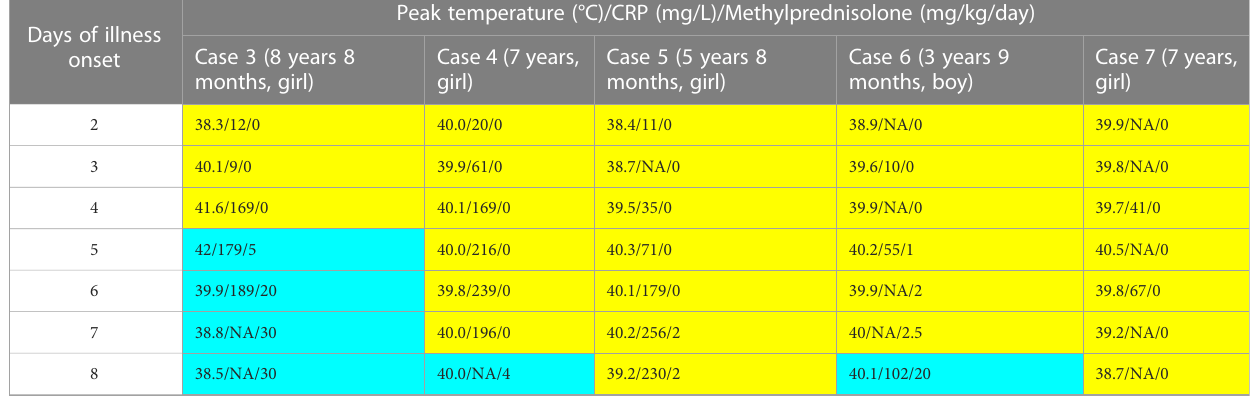
Days of illness